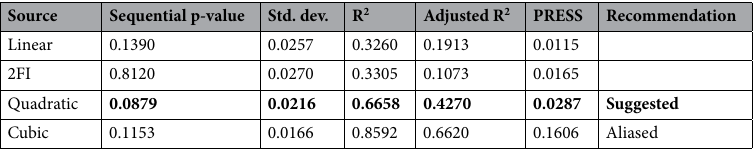
Table 13. Model summary statistics of high peaks zone for QAM f steel. Significant values are in bold.